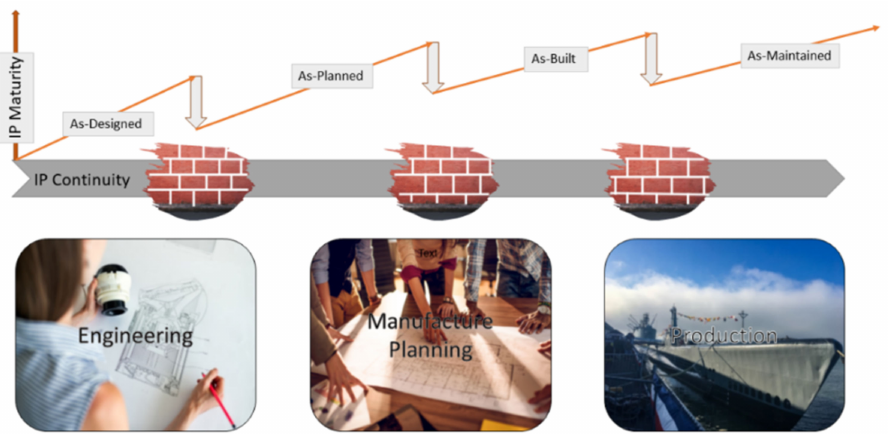
Figure 10. Management of intellectual property to ensure its continuity and filling the missing